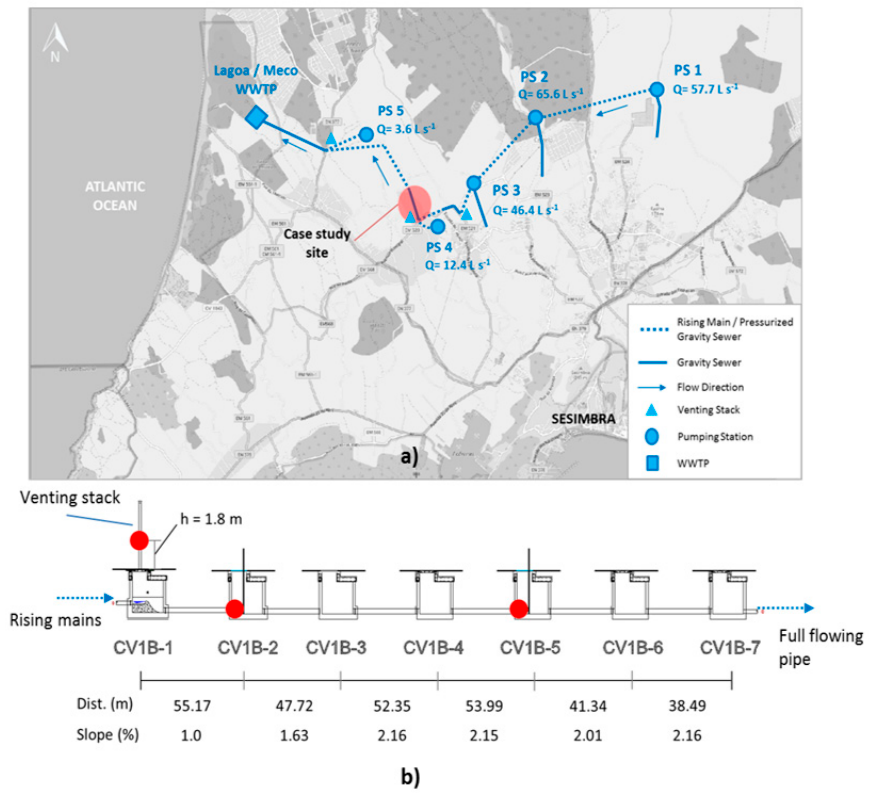
Figure 1. Location of Meco wastewater system ( a ); and schematization of experimental apparatus at Rua das Flores trunk sewer (red circles indicate probe placement) ( b ).